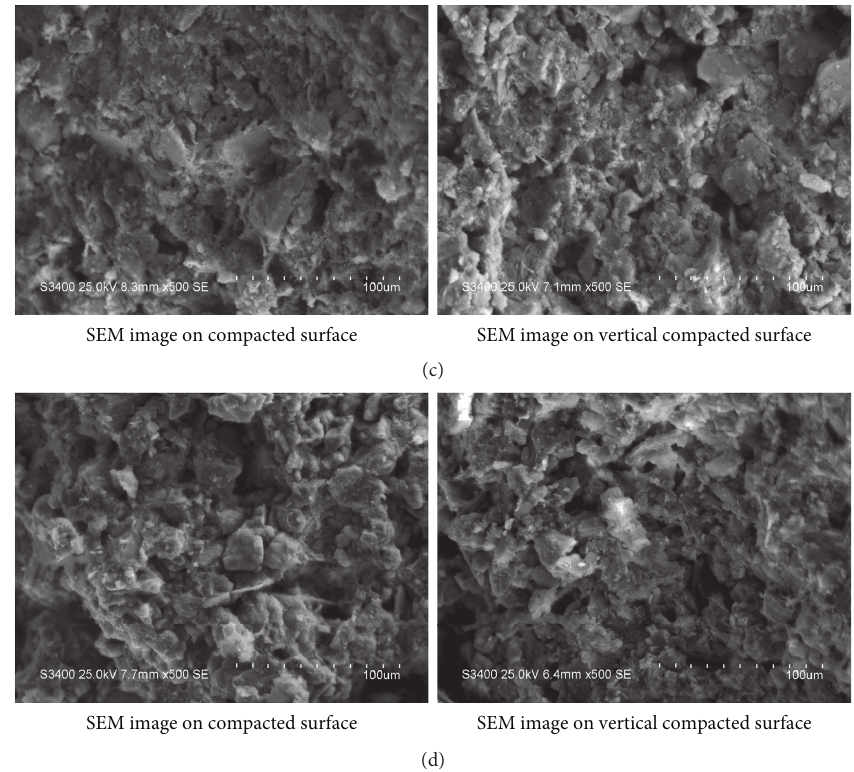
Figure 15: SEM images with different dry densities (500 times). (a) ρ